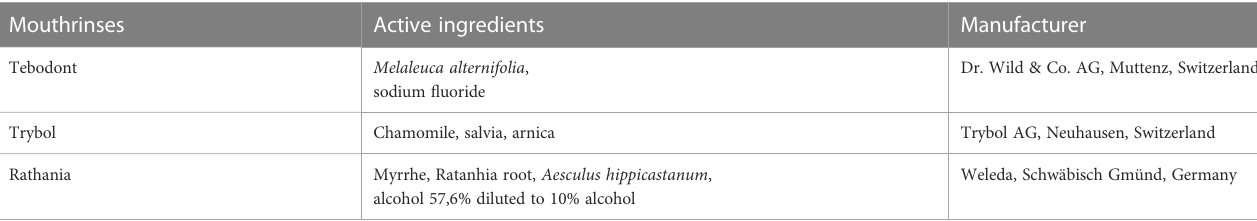
TABLE 1 Overview of the tested herbal mouthrinses, their active agents and the respective manufacturers.